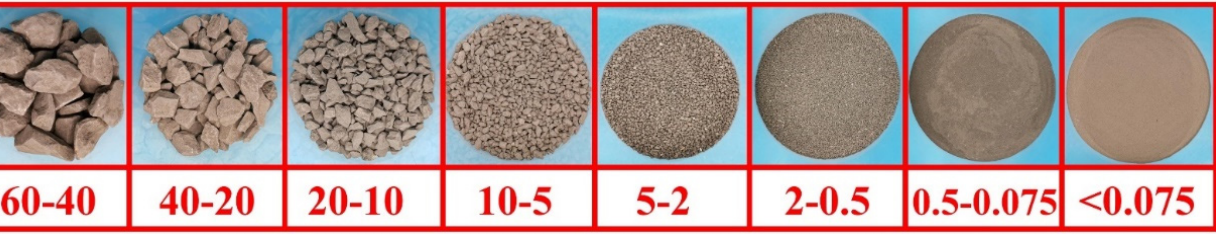
Figure 2. Coal gangue particles after sieving tests. Figure 3. The LSDSTA can automatically collect test parameters, such as axial load and displacement, confining pressure, pore pressure, and volumetric strain, as well as realize the static shear test and cyclic dynamic loading test. In addition, the large-scale triaxial tests and the same specimen size were widely used in the previous studies, e.g., Cai et al. [20] and Leng et al. [21], which guarantees the reliability of this